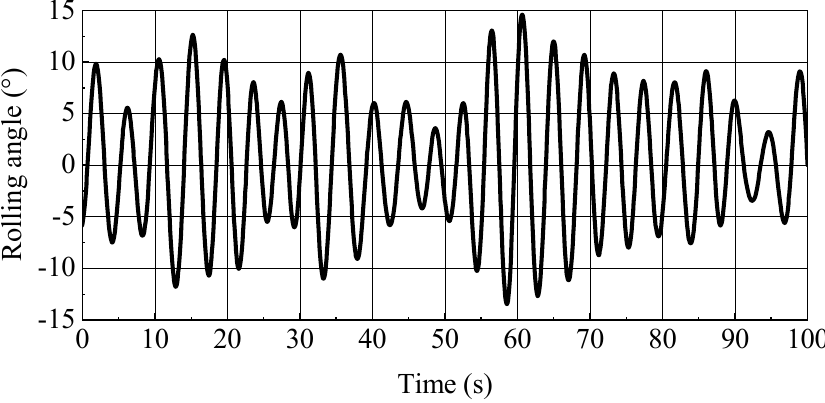
Figure 7. Time-series roll motion of the actual ship with zero forward speed in beam waves.